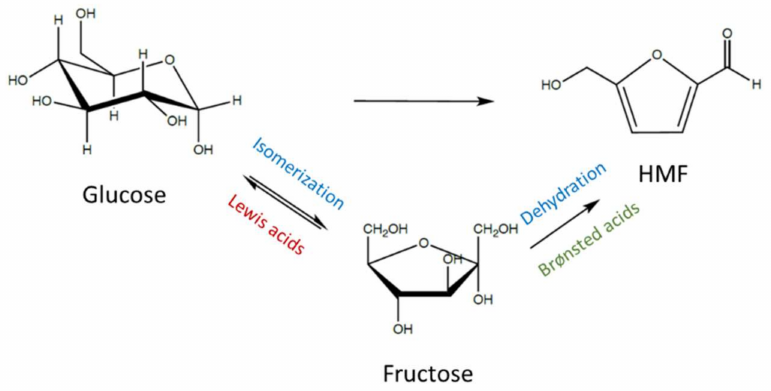
Figure 5. Brønsted/Lewis acid catalyzed conversion of glucose to